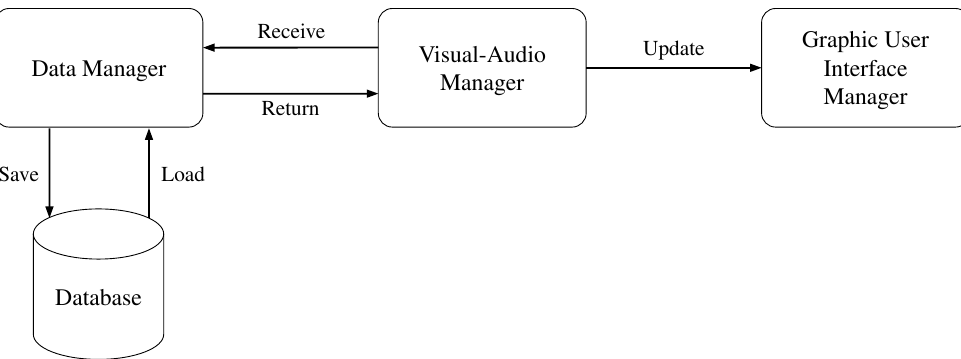
Figure 6. A simple diagram showing relationship between each software